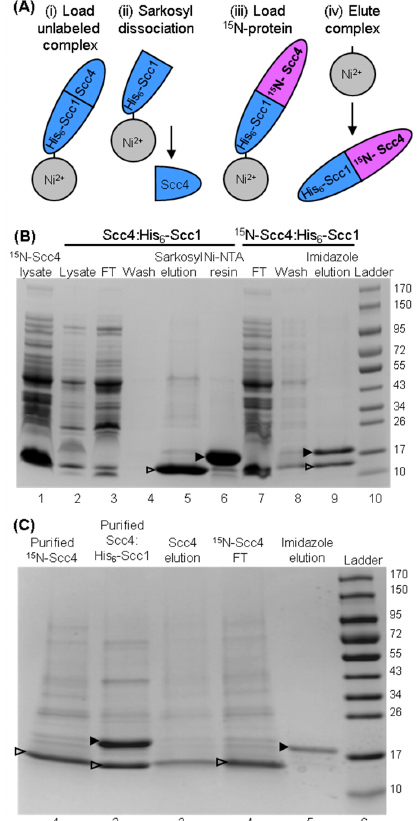
Figure 3. Preparation of chain-selectively labeled complex using on-column association with 15 N-Scc4 in clarified lysate or purified 15 N-Scc4. ( A ) Scheme for making chain-selectively labeled complex on-column. The unlabeled, in vivo-associated complex is ( i ) loaded onto Ni-IMAC resin and washed. ( ii ) Sarkosyl buffer is used to dissociate the complex resulting in the elution of unlabeled Scc4. Wash buffer is used to remove residual sarkosyl from the immobilized His 6 -Scc1. ( iii ) 15 N-labeled Scc4 is loaded and associates with His 6 -Scc1 on the column. The complex is washed to remove excess 15 N-Scc4, and ( iv ) the chain-selectively labeled complex is eluted with imidazole buffer. The Scc4: 15 N-His 6 -Scc1 complex is made by switching the labeled components, i.e., 15 N-labeled complex in ( i ) and unlabeled Scc4 in ( iii ). ( B ) SDS-PAGE analysis of the on-column association of immobilized His 6 -Scc1 and 15 N-Scc4 in clarified lysate. Clarified lysate samples containing 15 N-Scc4 and unlabeled, co-expressed Scc4:His 6 -Scc1 complex are shown in lanes 1 and lane 2, respectively. The immobilization of His 6 -Scc1 onto Ni-IMAC resin is shown in lanes 3–6 with samples of the Scc4:His 6 -Scc1 lysate that flowed through the resin (lane 3), wash (lane 4), sarkosyl elution of Scc4 from the immobilized Scc4:His 6 -Scc1 complex (lane 5), and Ni-IMAC resin with immobilized His 6 -Scc1. On-column association of 15 N-Scc4 with the immobilized His 6 -Scc1 is shown in lanes 7-9 with the 15 N-Scc4 lysate that flowed through the resin (lane 7), the wash (lane 8), and the imidazole elution of the 15 N-Scc4:His 6 -Scc1 complex (lane 9). ( C ) SDS-PAGE analysis of the on-column association using purified 15 N-Scc4 (lane 1) and co-expressed Scc4:His 6 -Scc1 (lane 2). Unlabeled Scc4 was eluted from the immobilized Scc4:His 6 -Scc1 complex (lane 3). The Ni-IMAC resin was washed, and the purified 15 N-Scc4 sample was loaded onto the resin (the sample that flowed through the resin is shown in lane 4). Lane 5 is the sample that eluted from the Ni-IMAC resin using imidazole bu ff er. Scc4 (14.7 kDa) and His 6 -Scc1 (18.8 kDa) bands are indicated with an open and closed arrow head, respectively. Lane 10 in ( B ) and lane 6 in ( C ) are the